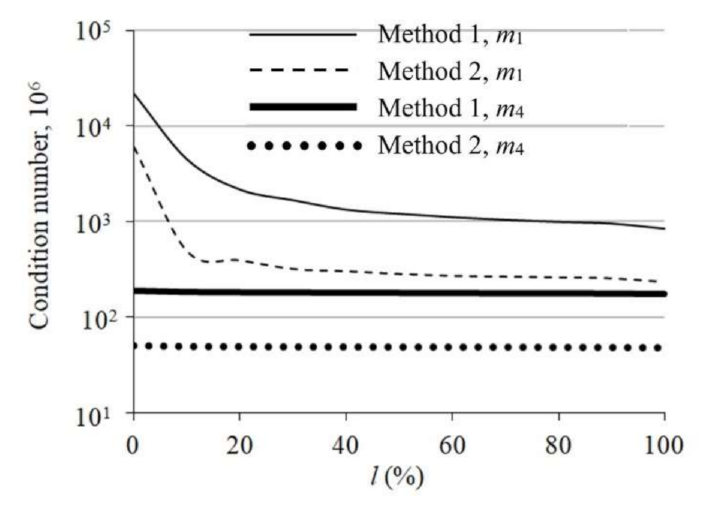
Figure 9. The condition number in the state-estimation process for load level V 0.5 .